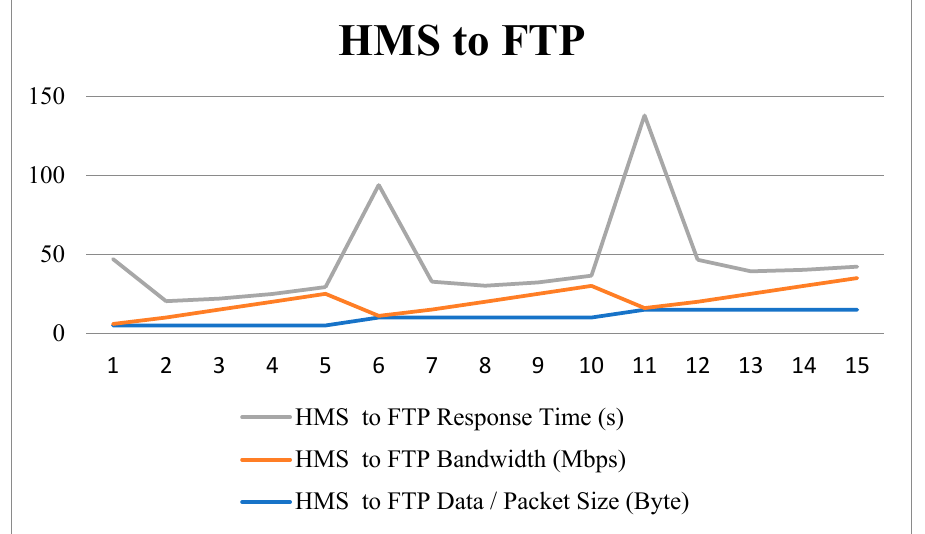
Table 4. HMS To FTP (Internet) .